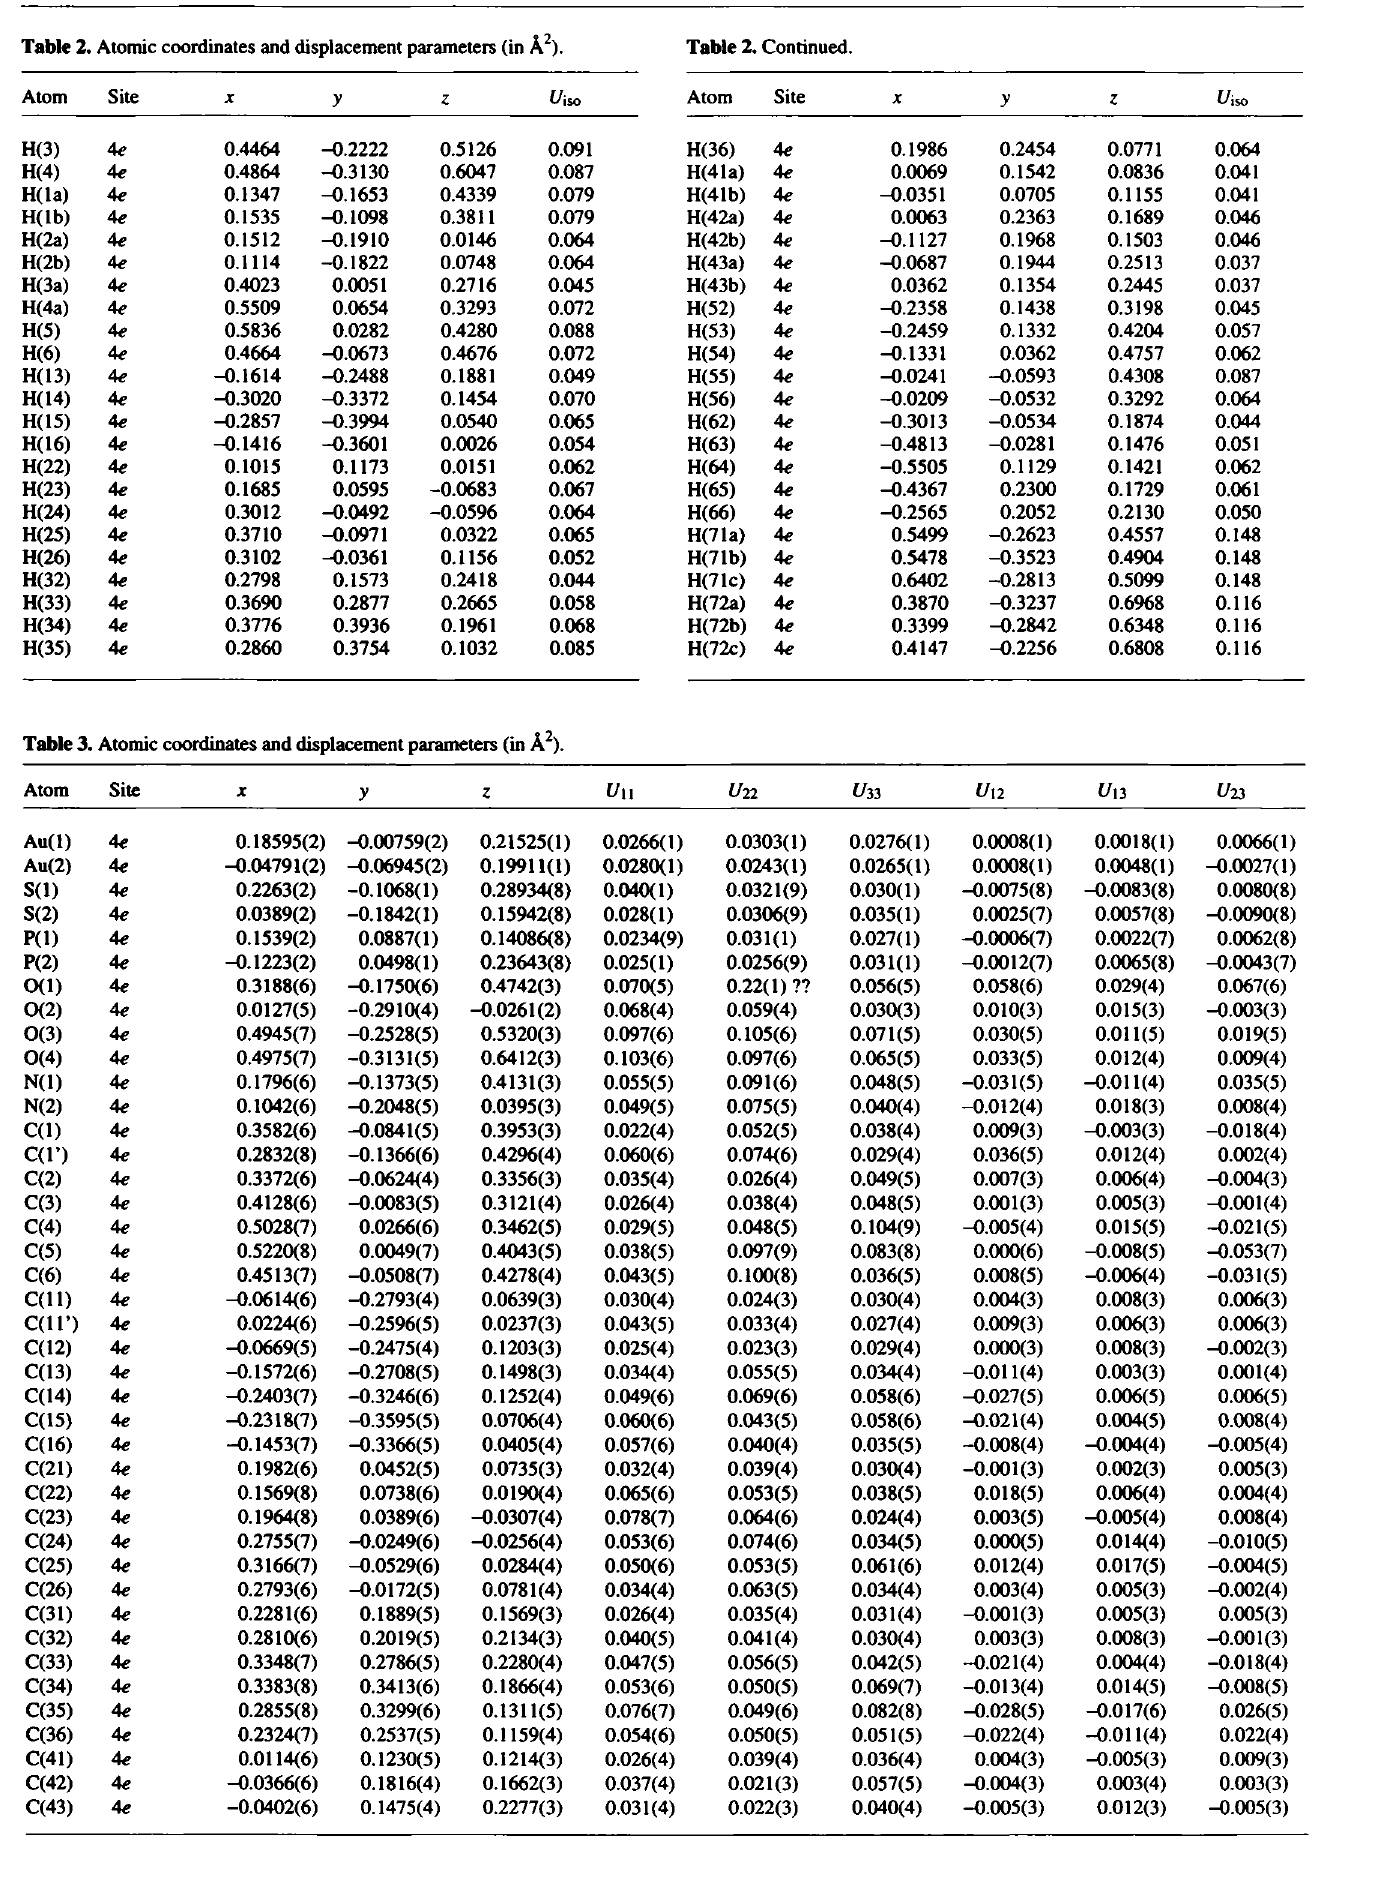
Table 3. Atomic coordinates and displacement parameters (in Â 2